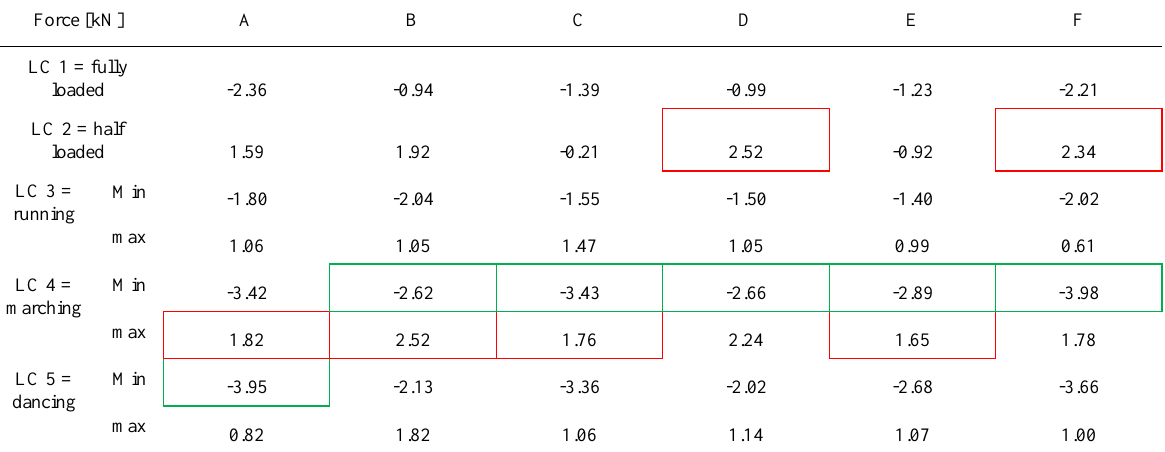
Table 2: showing forces in the diagonals for the different loading scenarios